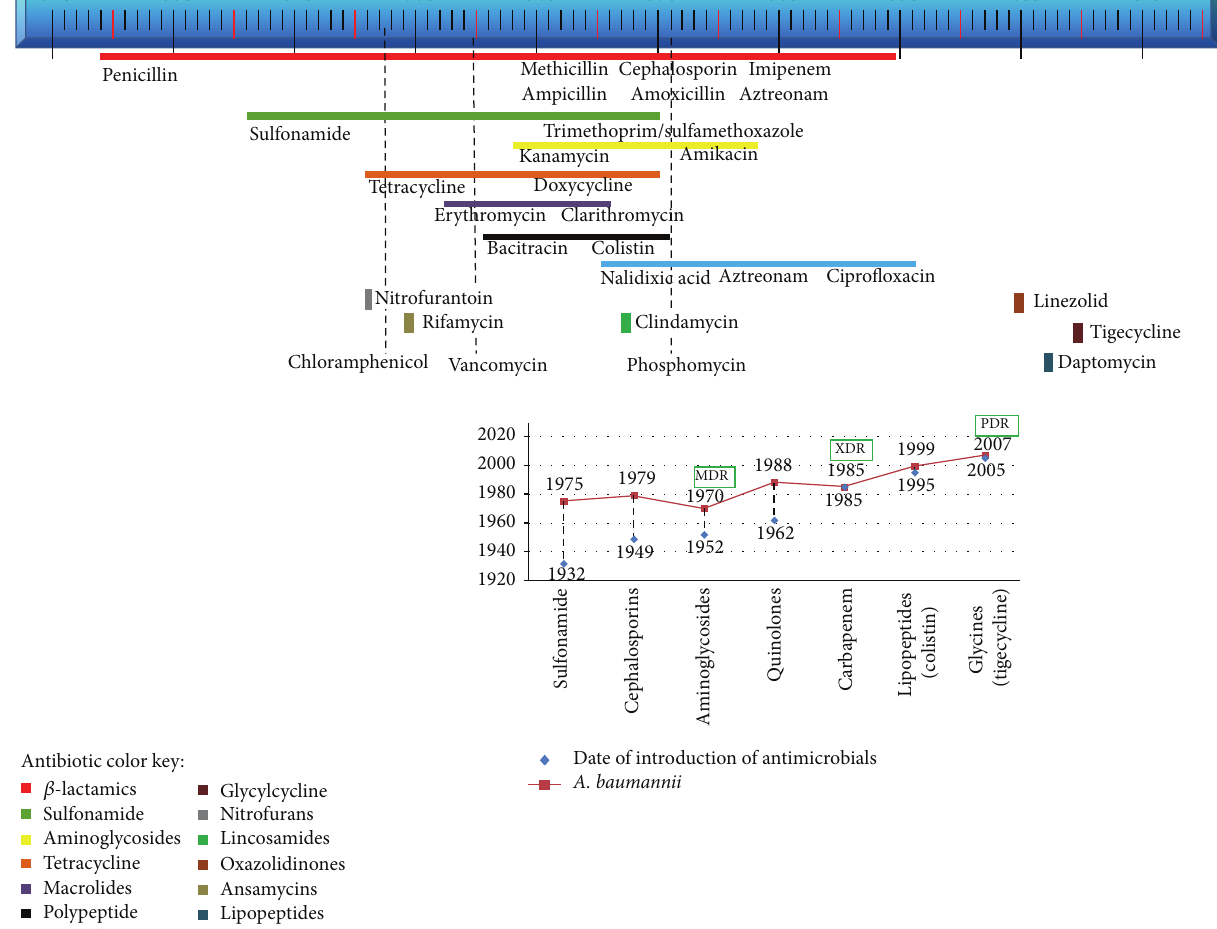
Figure 1: Top diagram shows dates of introduction of antimicrobials; relevant examples are indicated below colored lines for some groups. Dashed lines indicate antibiotics without group. Insert graph shows the date of introduction of antimicrobials, date of first reports of antimicrobial resistance in A. baumannii , and the emergence of multidrug-resistant (MDR), extensively drug-resistant (XDR), and pandrug- resistant (PDR) bacterial strains. Dashed lines indicate interval between antibiotic introduction and first report of resistance in A. baumannii